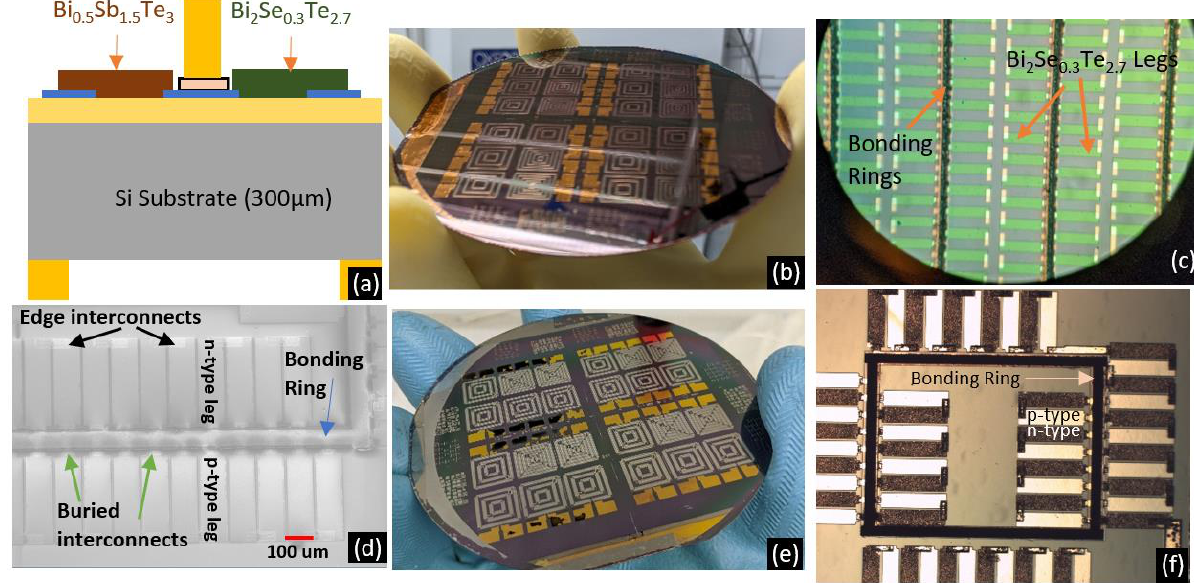
Figure 13. ( a ) Schematic view of the cross-section of one thermocouple after Stage 3 of fabrication. ( b ) Wafer view after evaporation and lift-off of n-type thin films. ( c ) Zoomed-in view of n-type thin films. ( d ) SEM image of a section of a single device after deposition of both p-type and n-type thermoelectric thin films. ( e ) Wafer view after both rounds of deposition. ( f ) Zoomed-in picture of a section of the device.